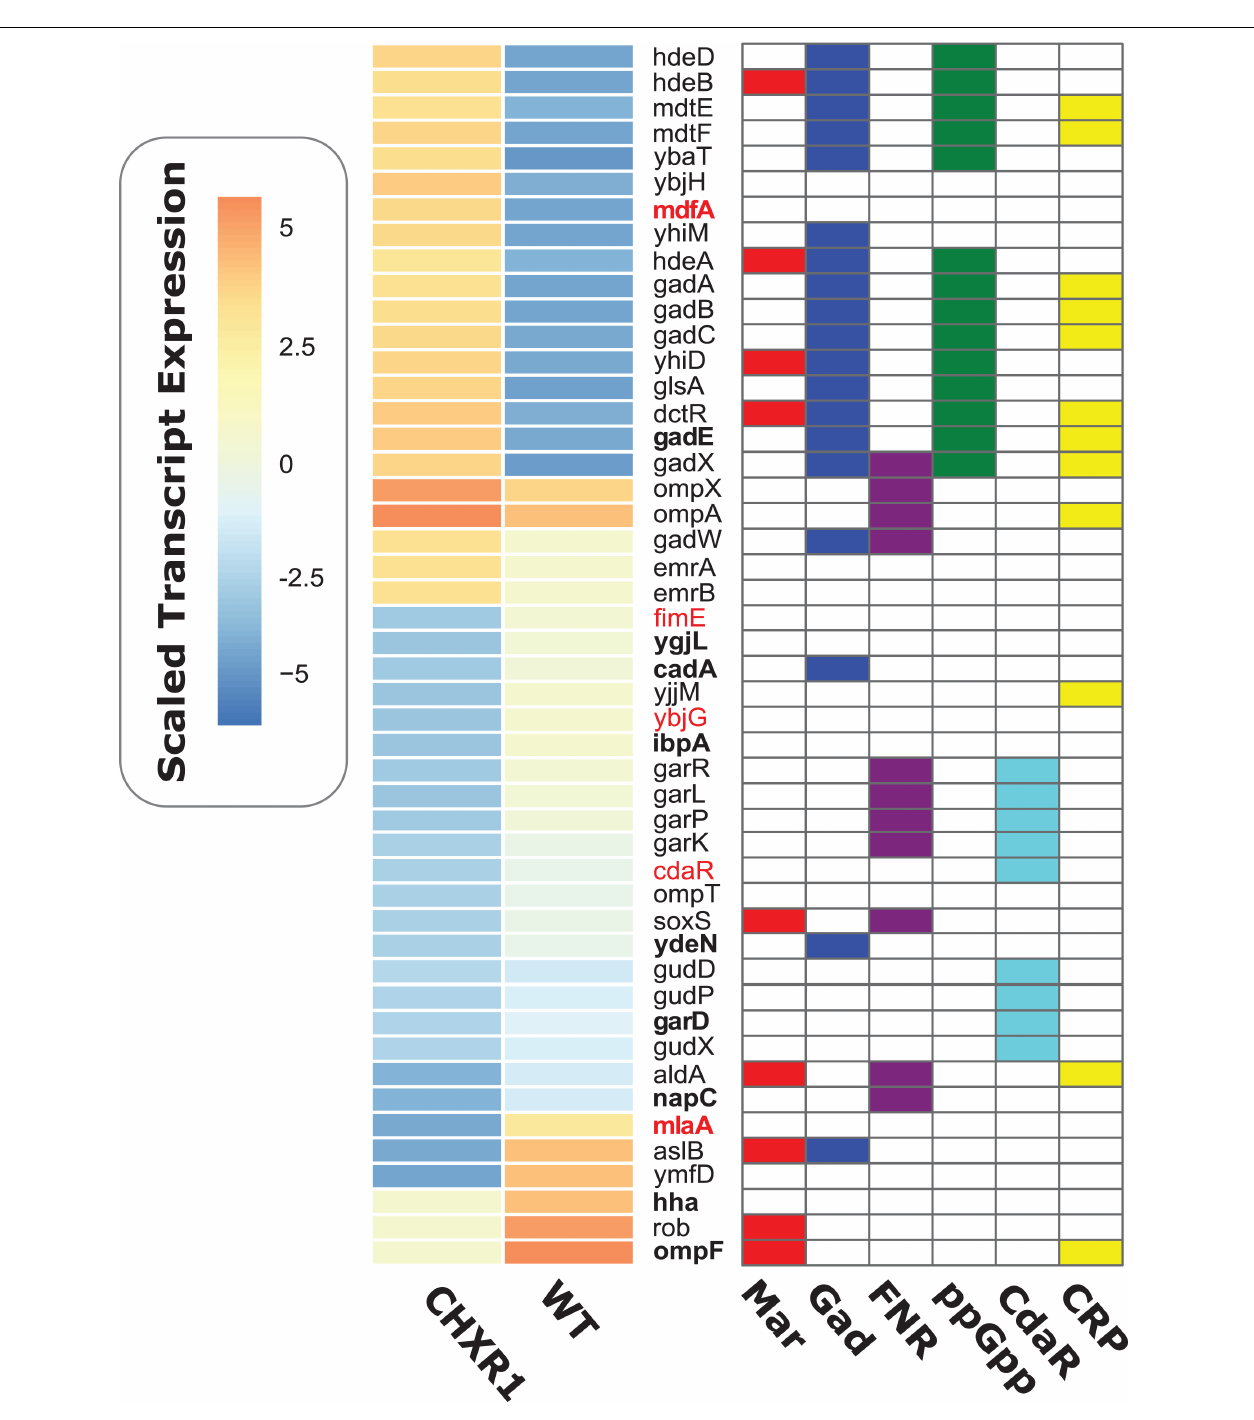
Frontiers in Molecular Biosciences |